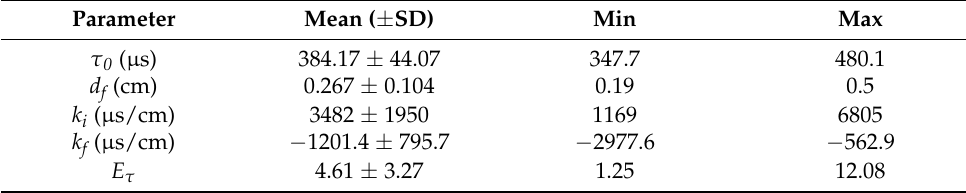
Table 2. Mean, minimum, maximum values and standard variation of parameters τ 0 , d i , d f , k i , k f and E τ describing the evolution of τ as a function of d for plywood samples.